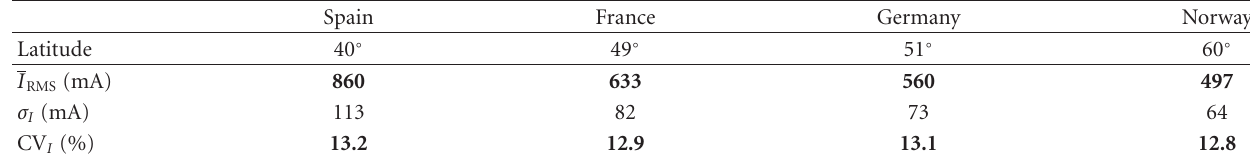
Table 1: Cell RMS current mean values, standard deviation, and coe ffi cient of variation.